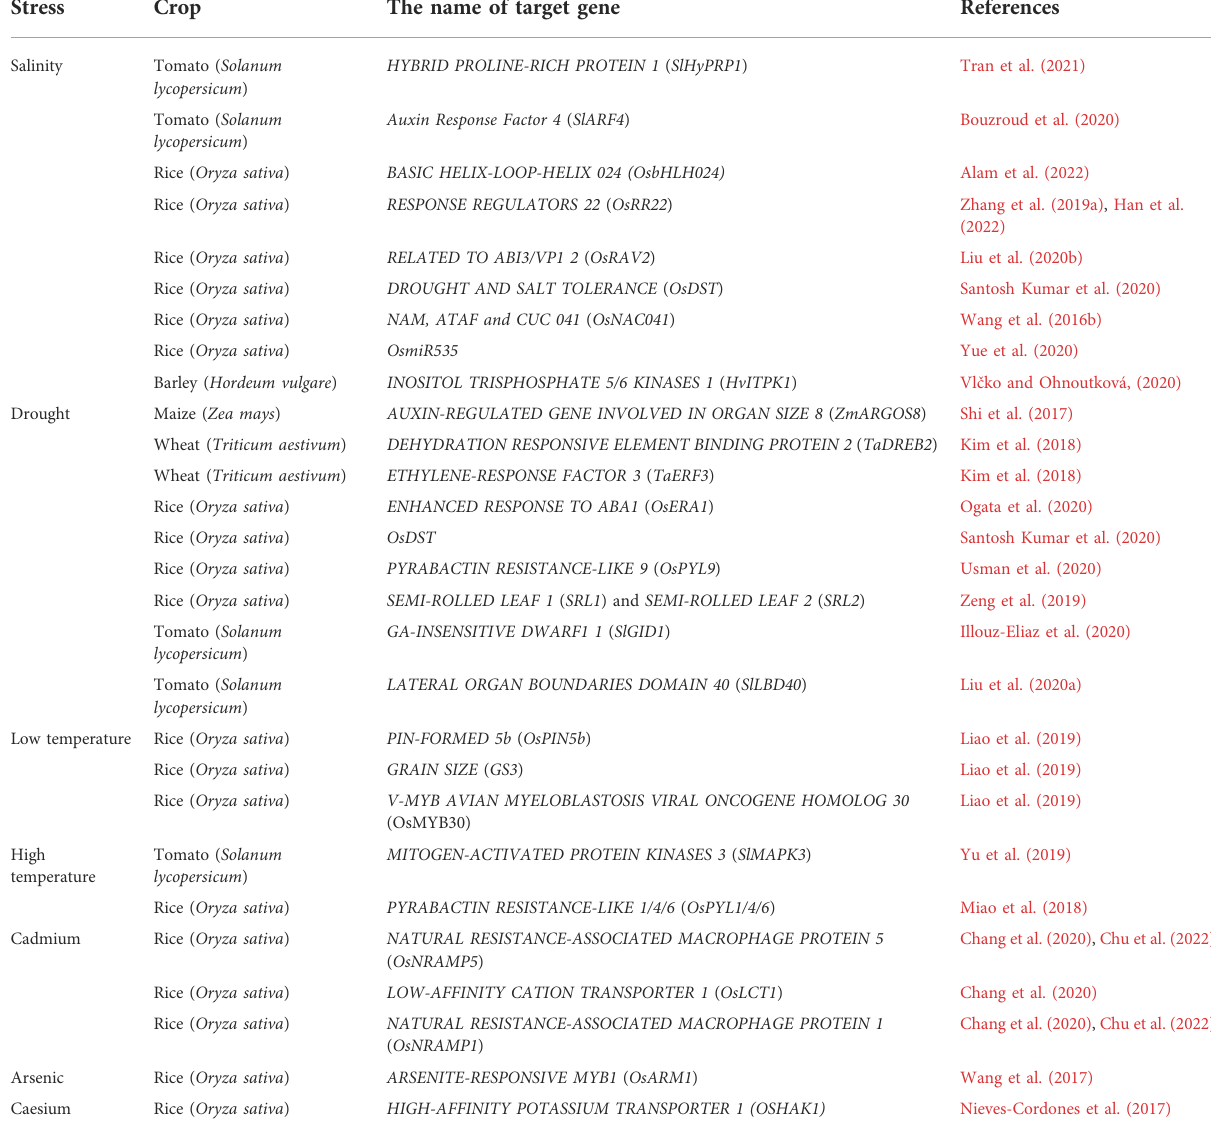
TABLE 1 Genes targeted by CRISPR/Cas system for imparting tolerance against abiotic